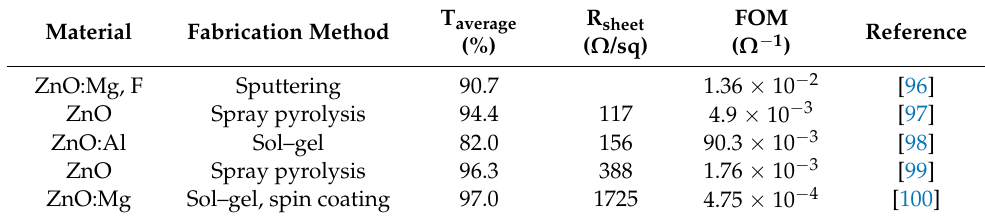
Table 3. Comparison of the reported values of T average , R sheet and FOM of ZnO-based thin films.